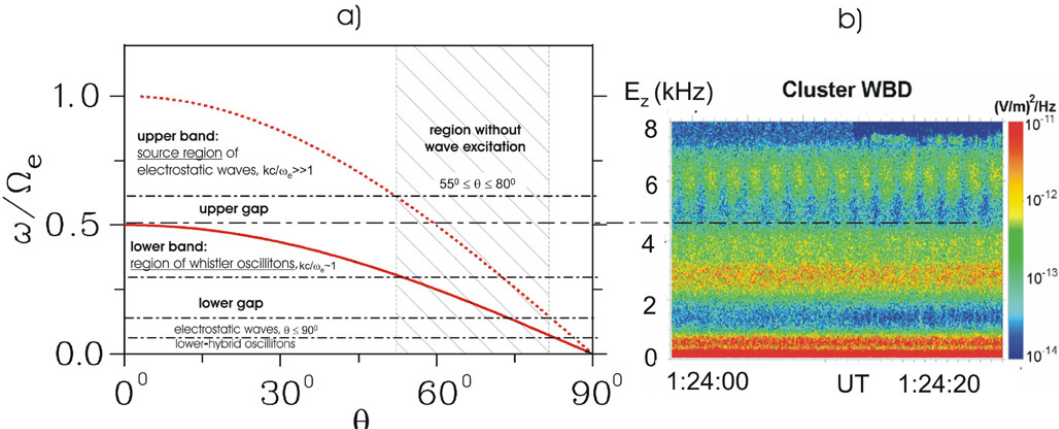
Fig. 17. Whistler wave bands and gaps in plasmas with G = (cid:127) e / ω e < 1. Left: the schematic view illustrates that the source region and the region of whistler-Langmuir oscillitons are well separated and that frequency bands and gaps exist below and above (cid:127) e /2. The red dotted curve corresponds to the resonance cone formula ω / (cid:127) e ∼ cos θ of the source region. The red solid curve represents the (Gendrin) oscilliton frequency versus the propagation angle θ according to ω / (cid:127) e = 0 . 5cos θ (see e.g. Sauer and Sydora, 2010). Right: frequency spectrogram, color coded in electric field intensity (adapted from Schriver et al., 2010). The WBD wave data show multiple bands and gaps of whistler wave emission, in reasonable agreement with the predictions in the left